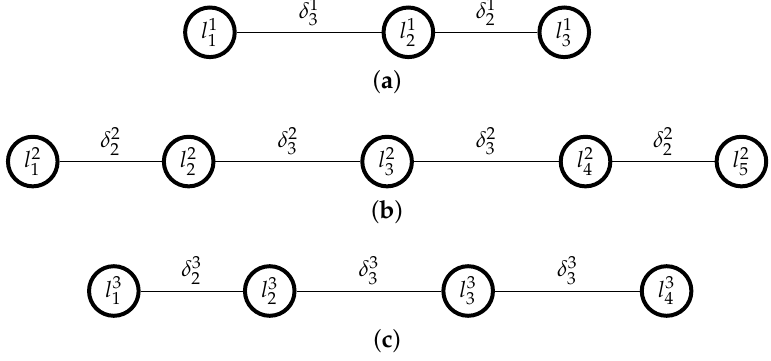
Figure 3. OPMs. Non-uniform case 2. ( a ) Metrizable OPM associated with the matrix A 32 ; ( b ) Metrizable OPM associated with the matrix A 2332 ; ( c ) Metrizable OPM associated with the matrix A 224 .